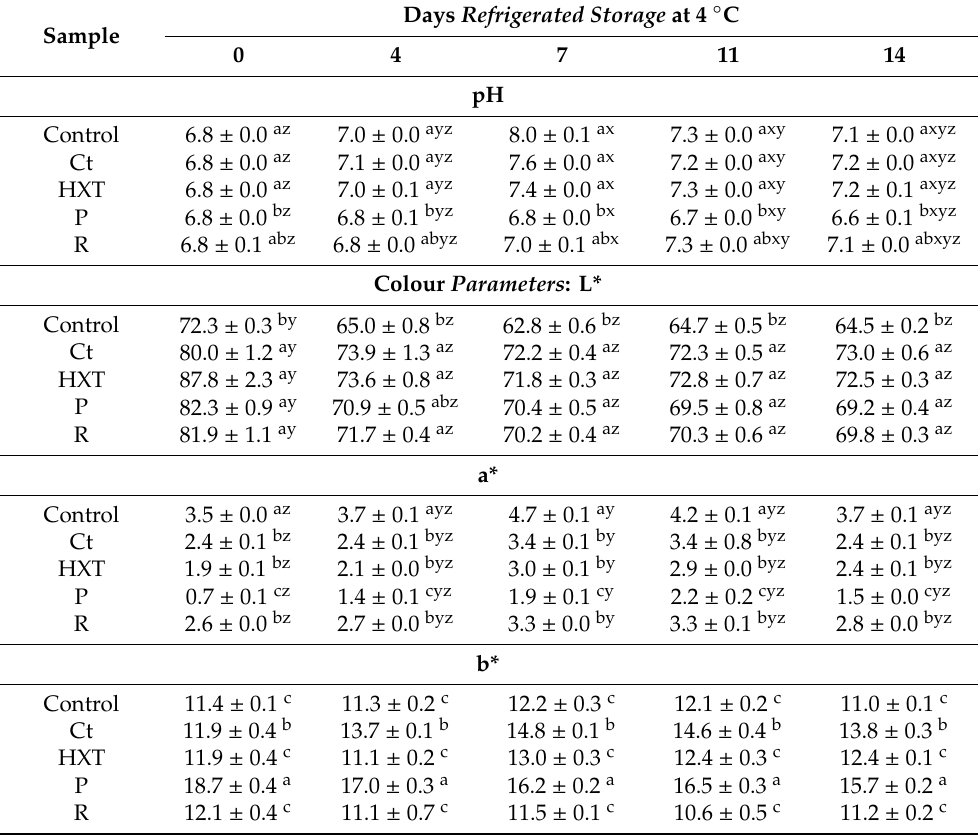
Table 3. pH and color (CIELab) (m ± s.e.) evolution of fish patty for 14 days under refrigerated storage. Sample